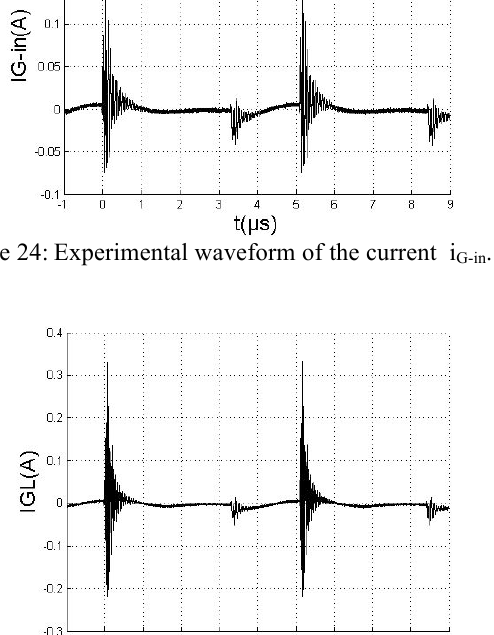
Figure 28: Experimental waveform of the current i . GL